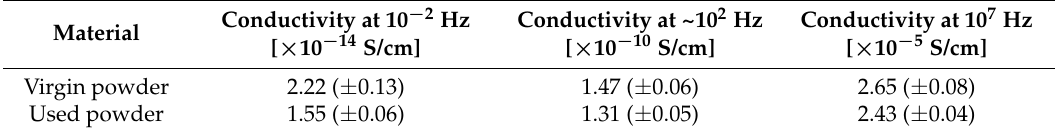
Table 1. Mean conductivities obtained by impedance spectroscopy measurements of virgin and aged PA12 for varying frequencies. Values in brackets represent the standard deviation over five measurements.